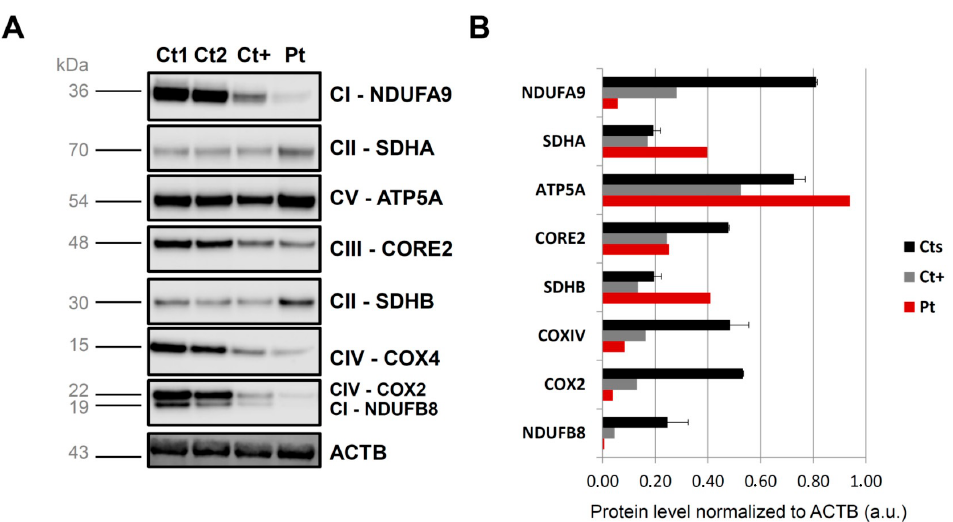
Figure 3. Steady-state levels of OXPHOS complex subunits. ( A ) Western blot analysis of OXPHOS subunits in skeletal muscle lysates from control individuals (Cts), a patient harboring biallelic C1QBP mutations (Ct+) and the patient described in the manuscript (Pt). OXPHOS subunit-specific antibodies were used against NDUFB8 or NDUFA9 (CI); SDHA or SDHB (CII); UQCRC2 (CIII); COXII or COXIV (CIV); and ATP5A (CV). Cytosolic b-actin (ACTB) was used as a loading control. ( B ) Graph reporting protein level normalized to ACTB (in percentage, 100% being the mean value of controls), for the Western blot depicted in panel A.